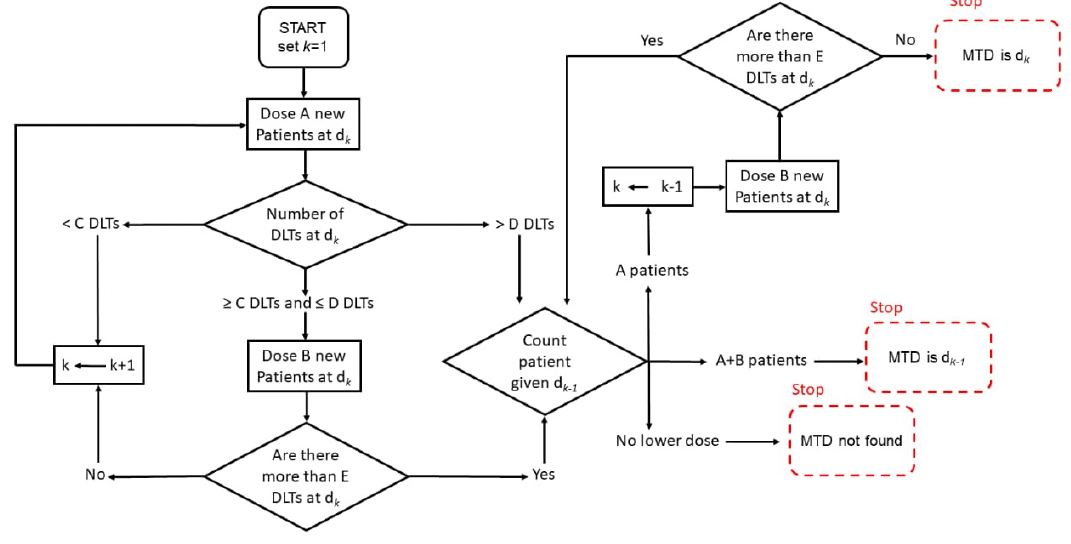
Figure 2. Schematic representation of A + B design with dose de-escalation. Lin and Shih (2001) investigated statistical properties of the A + B design and for- mulated the calculation of a dose being chosen as MTD, the expected number of